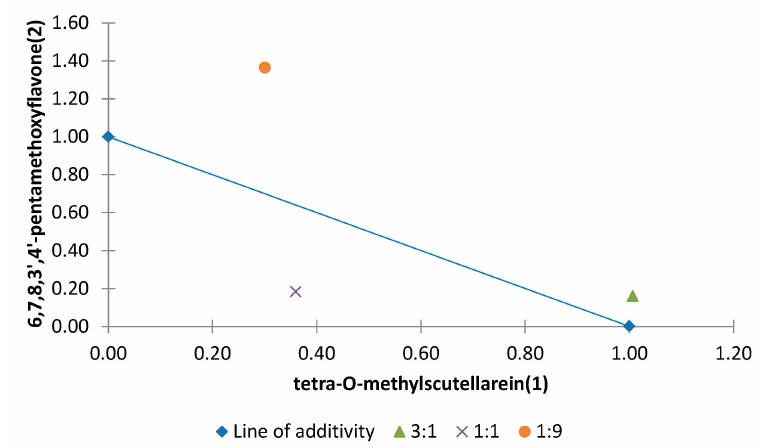
Figure 11. Normalized isobologram (ED 25 ) for the binary mixture tetra- O -methylscutallarein ( 1 )/6,7,8,3 1 ,4 1 -pentamethoxyflavone ( 2 ) in the etiolated wheat coleoptile bioassay. (Combination ratios 3:1; 1:1; 1:9). The combination ratio 3:1 did not show a significant difference on applying